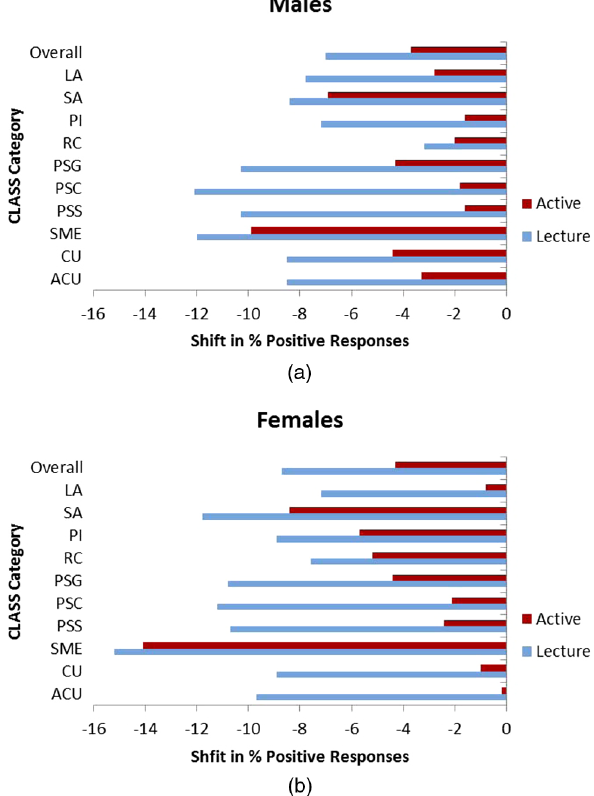
FIG. 6. CLASS shifts from pre-Fall to post-Spring for (a) males and (b) females. Significance tests were not conducted separately within each gender because no gender × instruction-type inter- action effects were significant in the whole-year